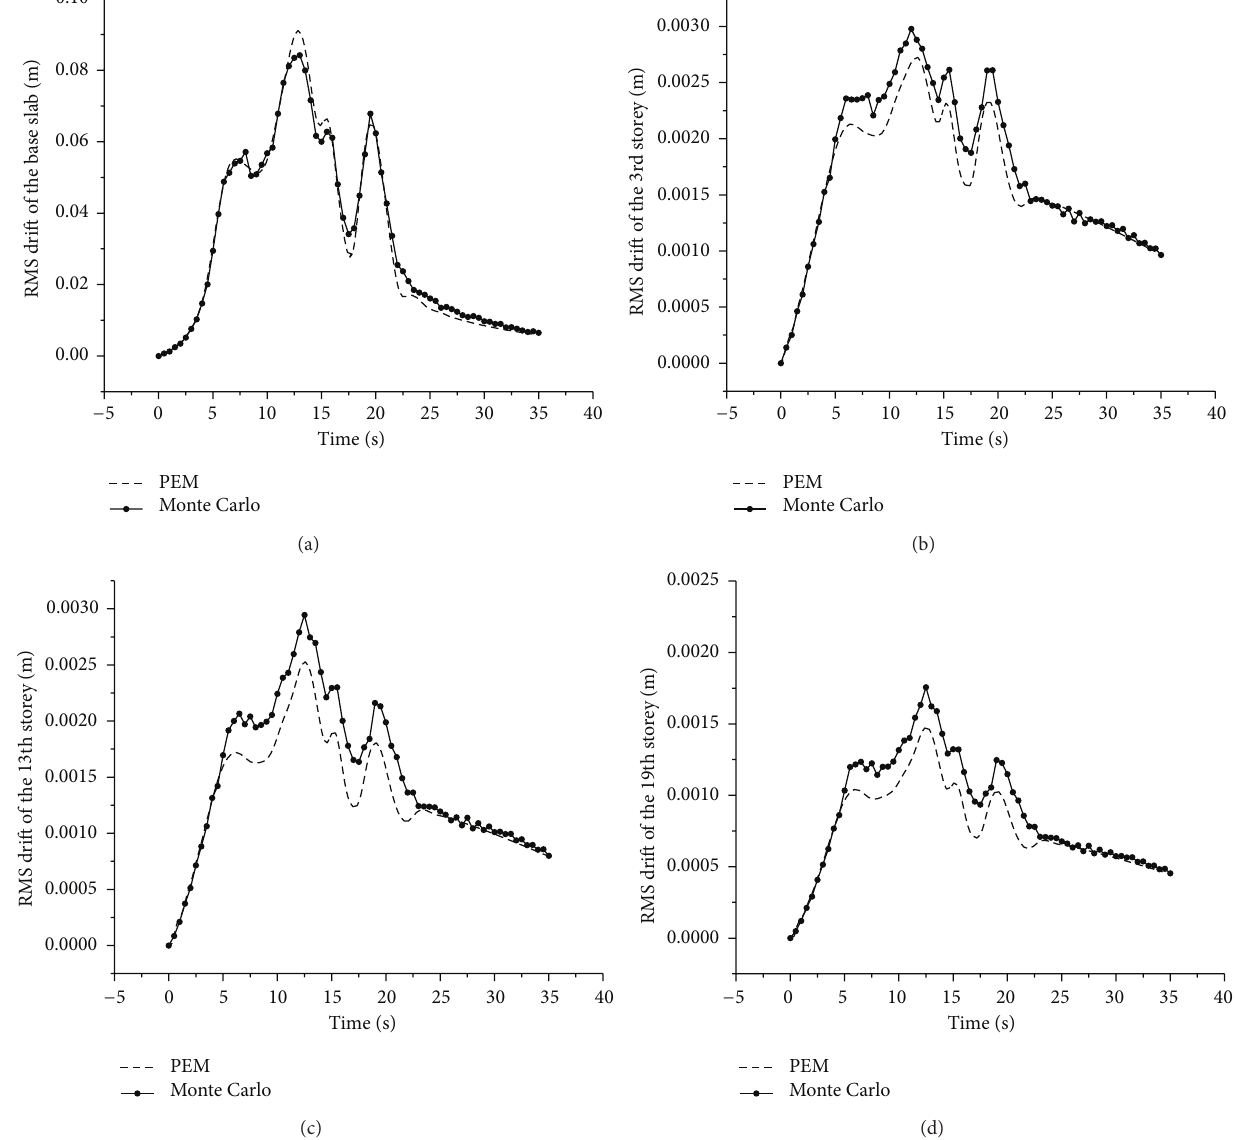
Figure 4: Comparison of the RMS storey drifts: (a) base slab, (b) 3rd storey, (c) 13th storey, and (d) 19th storey, evaluated by PEM with those obtained by Monte Carlo